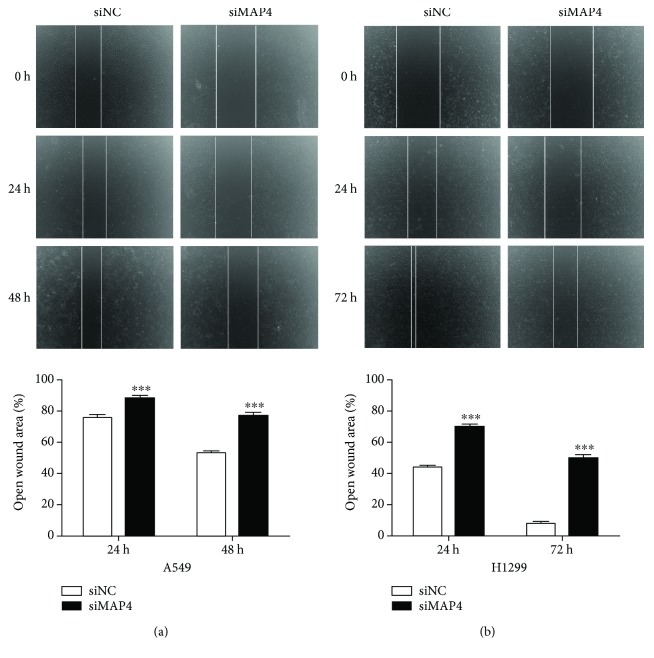
Effect of MAP4 knockdown on cell migration in vitro. Wound-healing assay was performed with both A549 (a) and H1299 (b) cells transfected with MAP4 siRNA or a negative control to examine the cell migration. The ability of cell migration was repressed after MAP4 knockdown in both A549 and H1299 cells. The open wound area was normalized to the area at the initial time (0 h). (a, b) Top: representative images. (a, b) Bottom: the percentage of filled wound area was calculated and represented as mean + SD relative to the control (∗∗∗P < 0.001, Student's t-test).